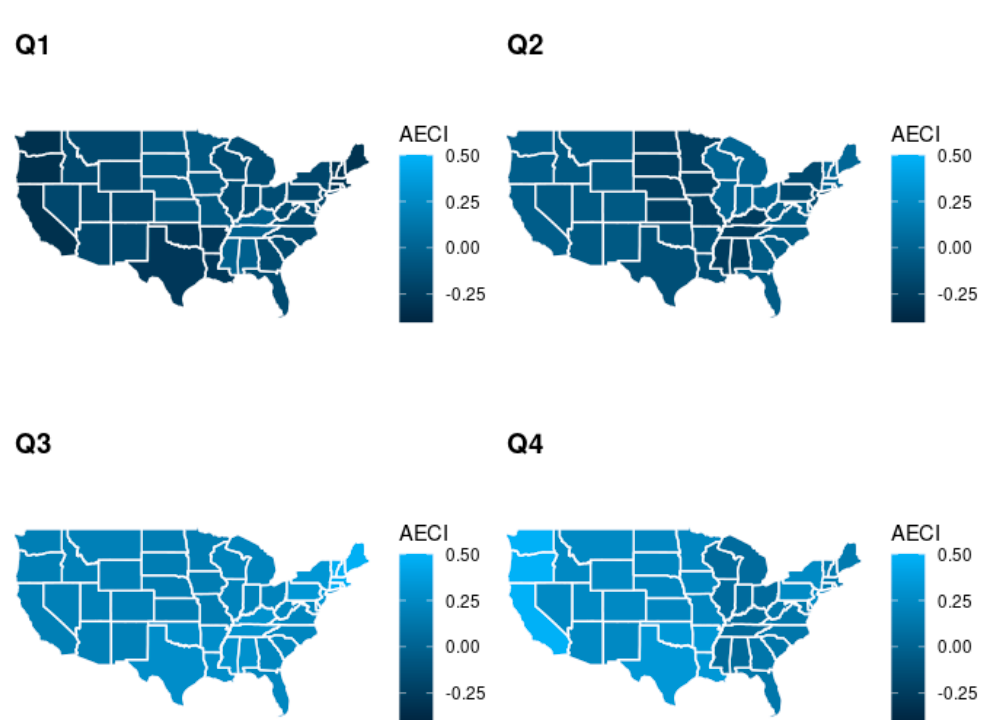
Figure 2. Average adjusted excess coding intensity (AECI) by U.S. Census Bureau regional division within each quarter in 2019.